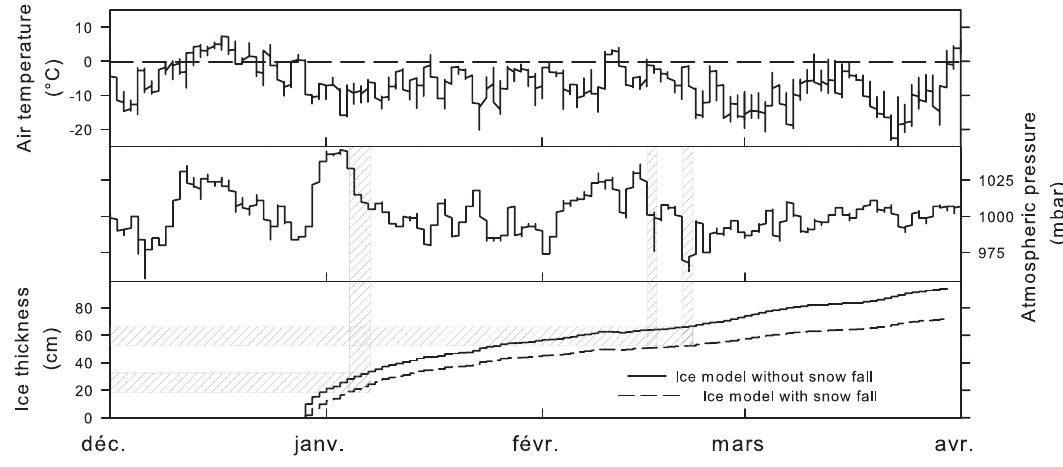
Fig. 9. Air temperature and atmospheric pressure versus modelled ice thickness from Eq. (2) (see text). The dotted line takes snow falls into account. Shadow hatchings show depth fitting with the air pressure drop events. The two highlighted drops correspond with the depth of the two synchronous bubbling events described in the text.